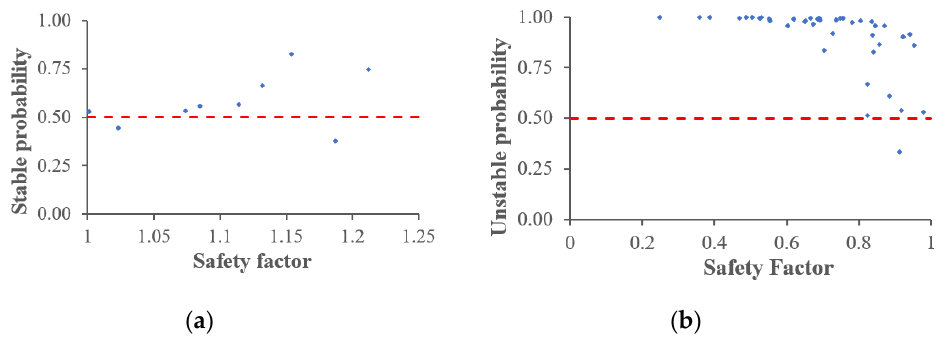
Figure 11. Prediction of the test data using the first classifier. ( a ) Stable probability of the samples with 𝐹 𝑠 ≥ 1 ; ( b ) unstable probability of the samples with 𝐹 𝑠 < 1 .